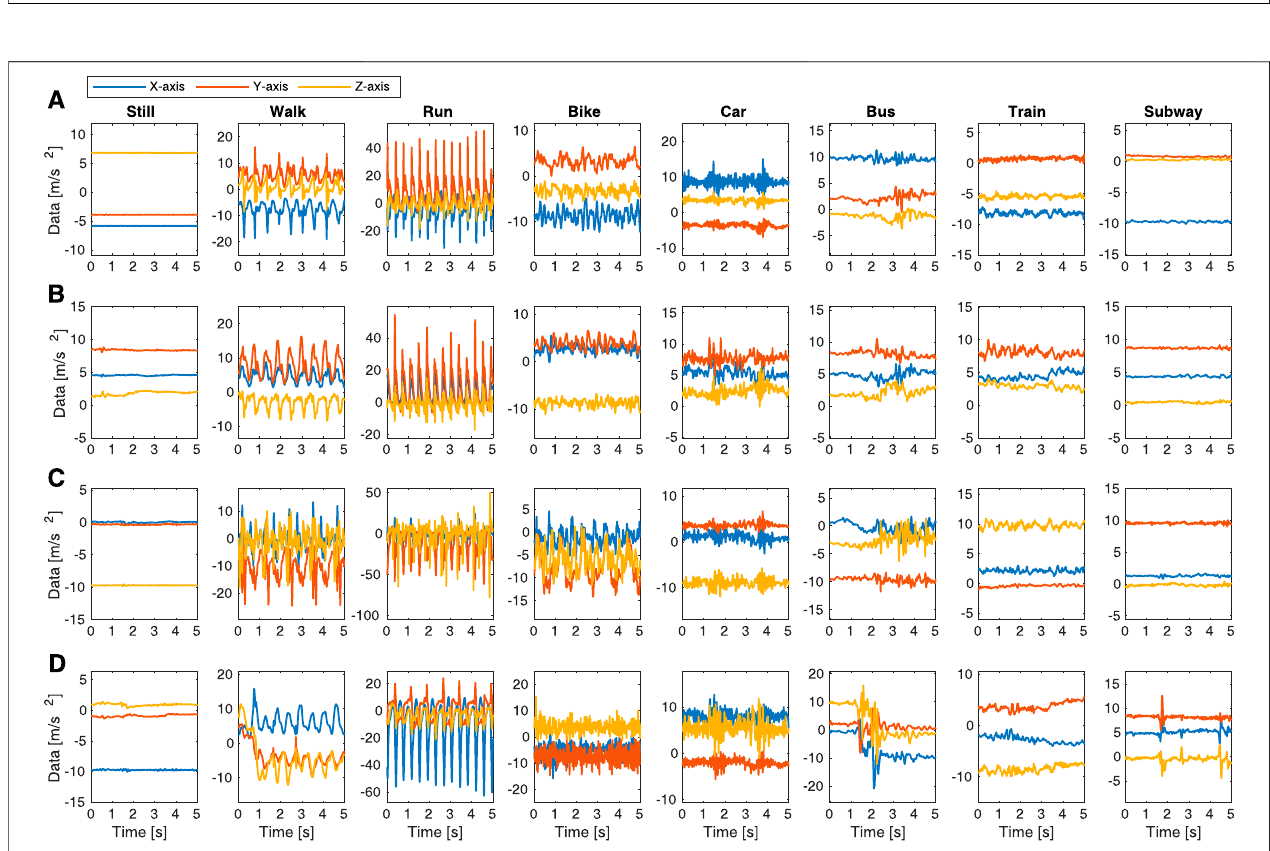
FIGURE 7 | Exemplary samples of accelerometer data in SHL 2019. The data is collected by User1 at four body position in the same time interval: (A) Bag; (B) Torso; (C) Hips; (D)